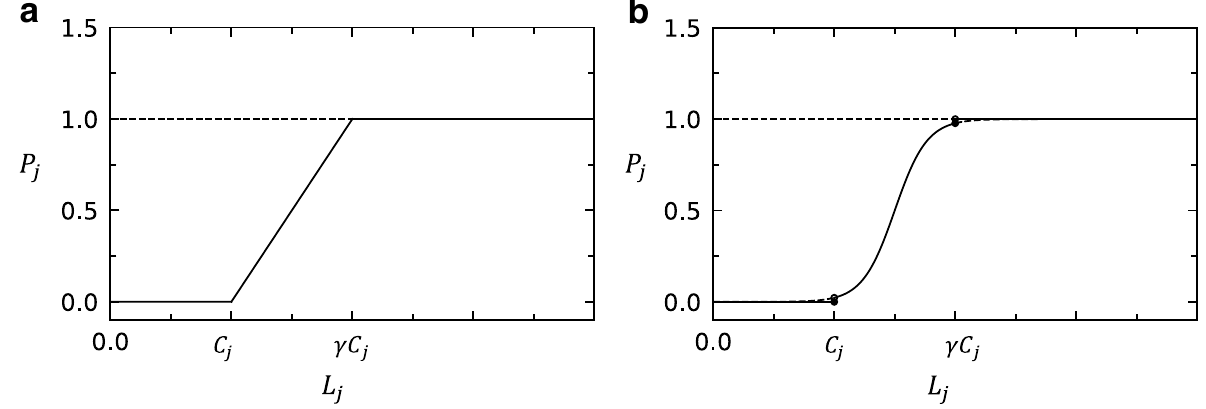
Figure 1. The probability of failure of node j , P j as a function of its load L j for ( a ) the linear model and ( b ) the logistic model. The value of P j is 0 when the load of node j , L j , is smaller than its capacity C j , and it is 1 when the load L j exceeds its removal threshold γ C j . For C j < L j ≤ γ C j , P j is described as as the logistic curve in Eq. (4) for the logistic